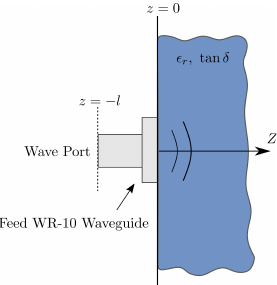
Figure 2. Representation of simulation setup for absorber (cid:101) r and tan δ characterization.